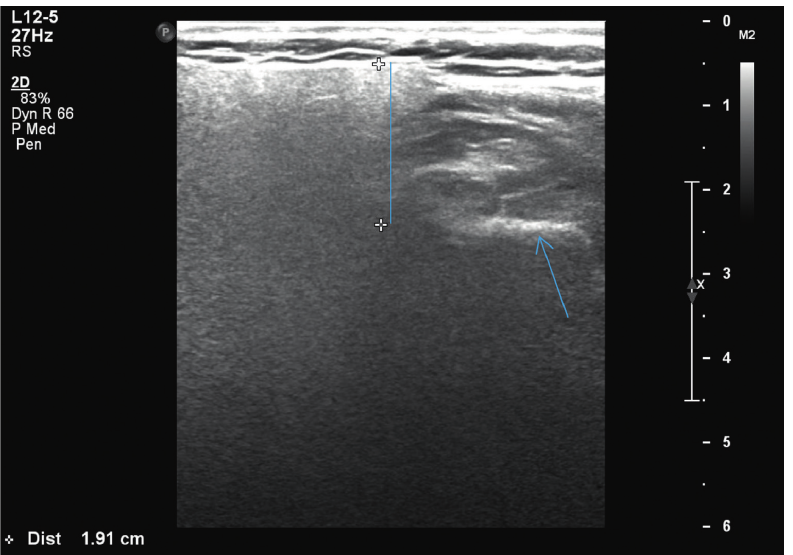
Figure 3: Right parotid gland measurement of depth lateral to mandible of patient with HbA1c 9.7.